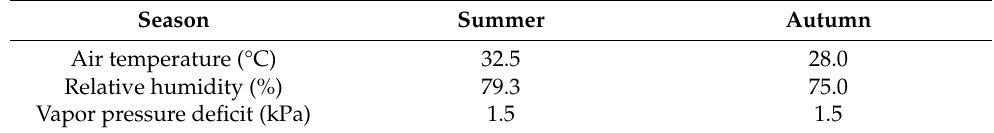
Table 2. Meteorological data during mandarin seasonal